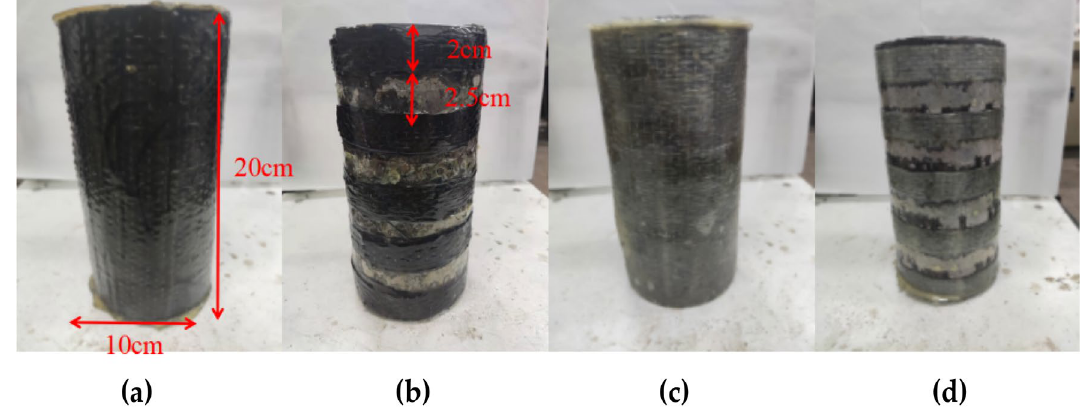
Figure 2. Confined style: (a) fully confined with CFRP; (b) semi-confined with CFRP; (c) fully confined with GFRP; (d) semi-confined with GFRP.